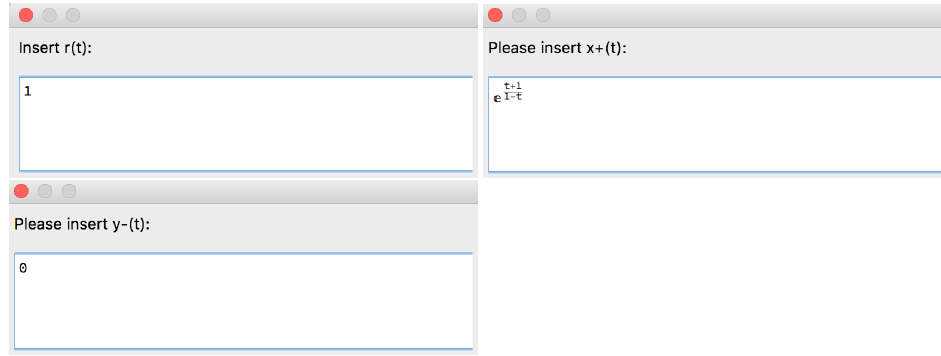
Figure 67. Piece of code removed from [SInt]